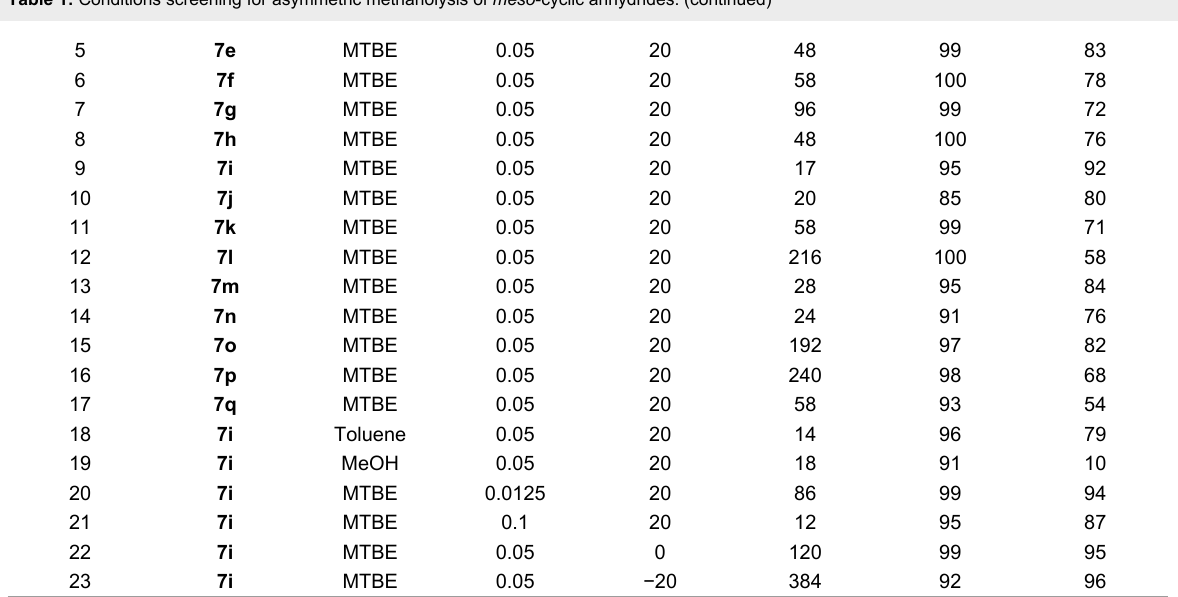
Table 1: Conditions screening for asymmetric methanolysis of meso -cyclic anhydrides. (continued)